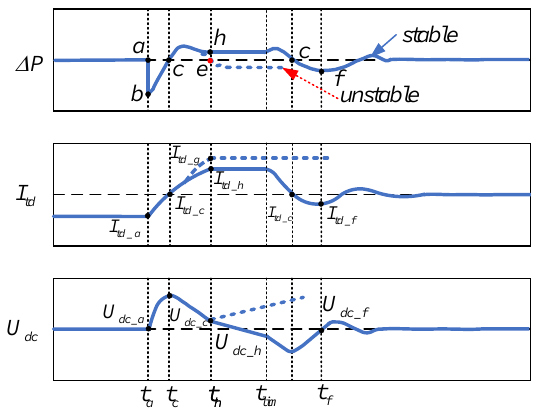
Figure 8. The theoretical oscillation waveforms of ∆ P, U dc , and I td during the transient process with the current limiter.